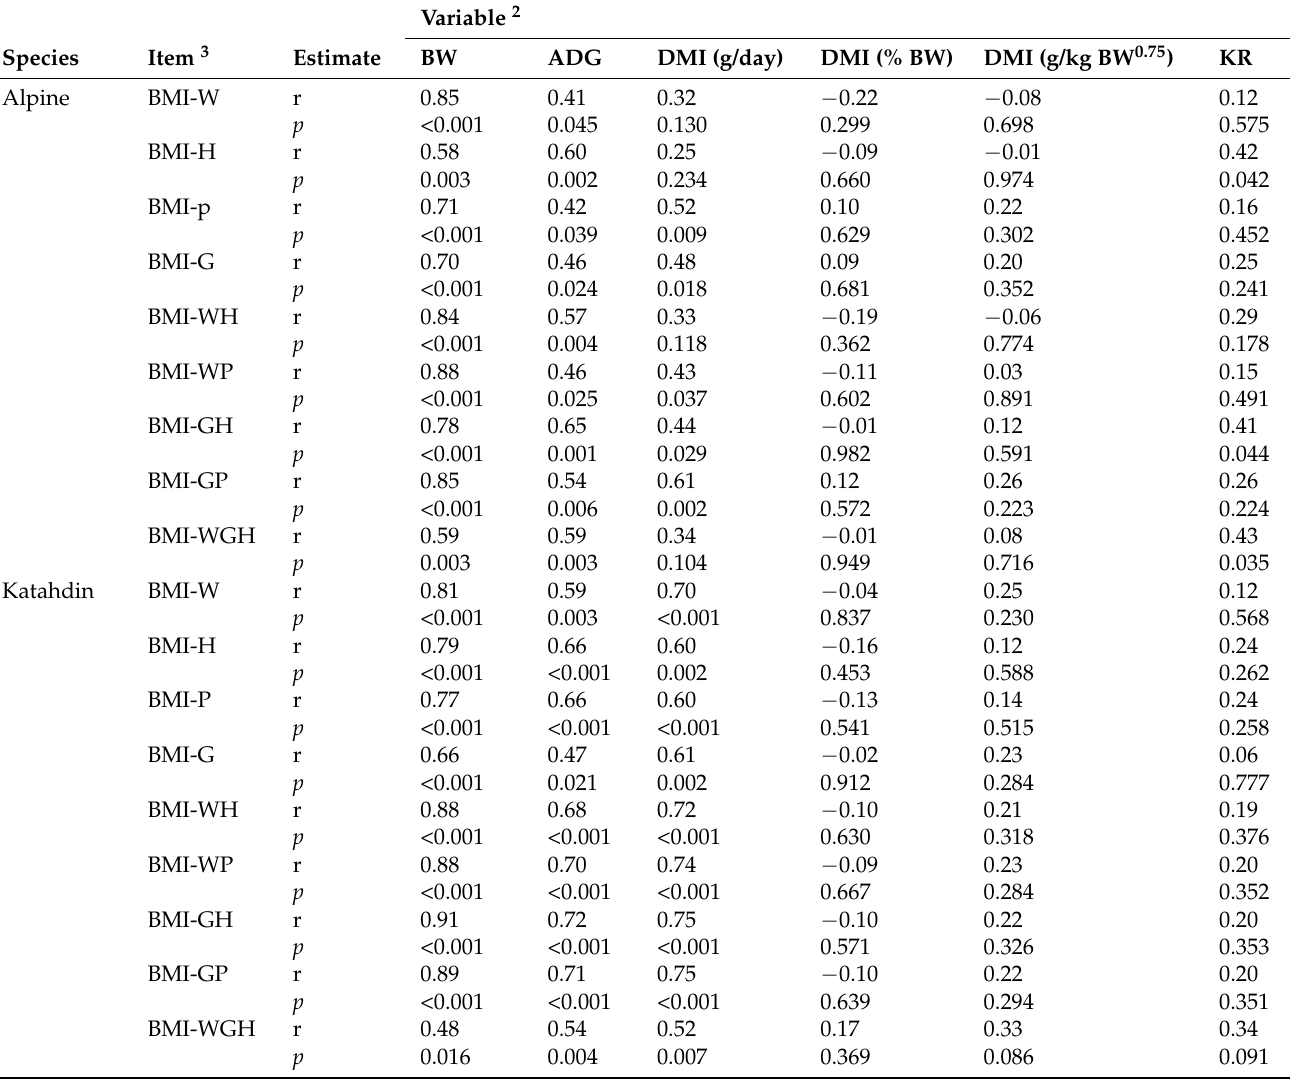
Table 5. Pearson correlation coefficients (r) between body mass indexes and body weight, average daily gain, dry matter intake, and Kleiber ratio 1 . Variable